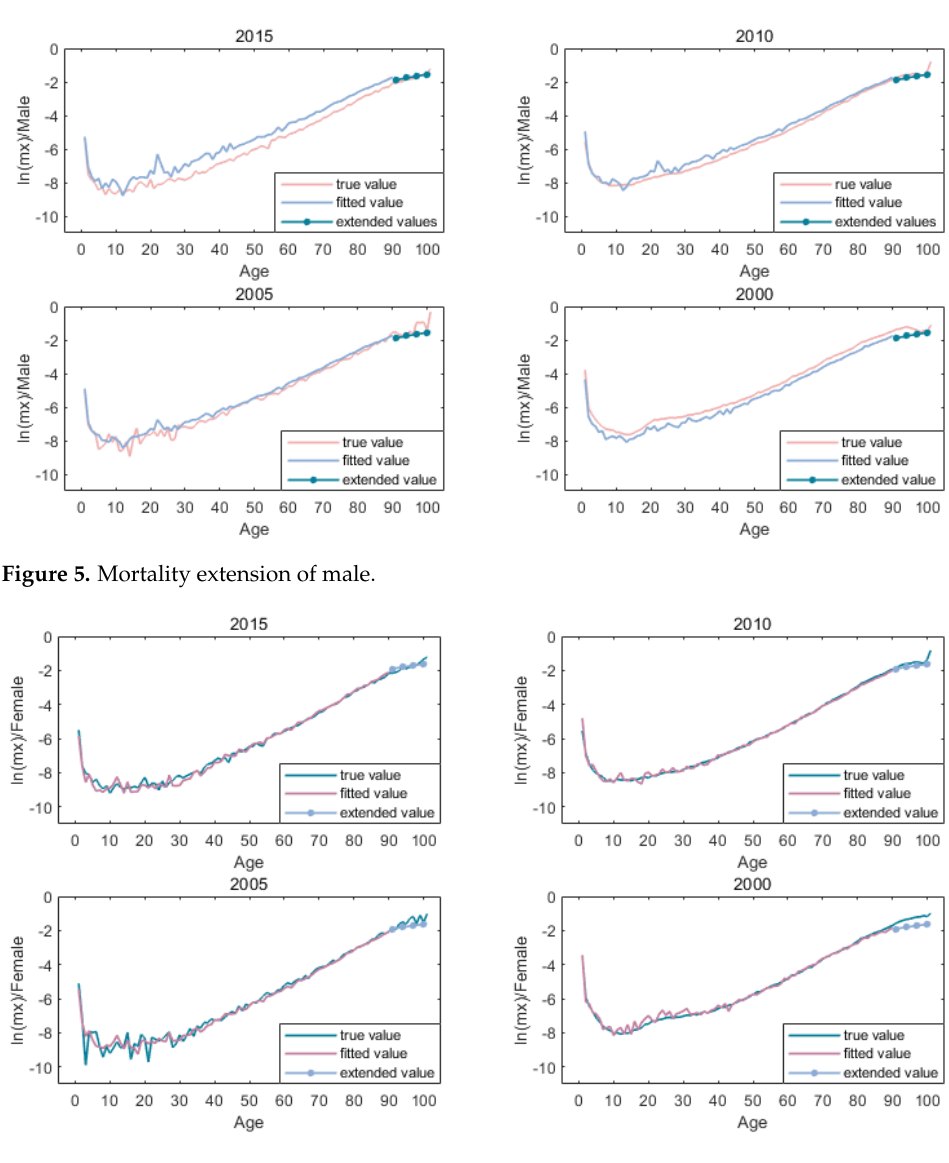
Figure 6. Mortality extension of